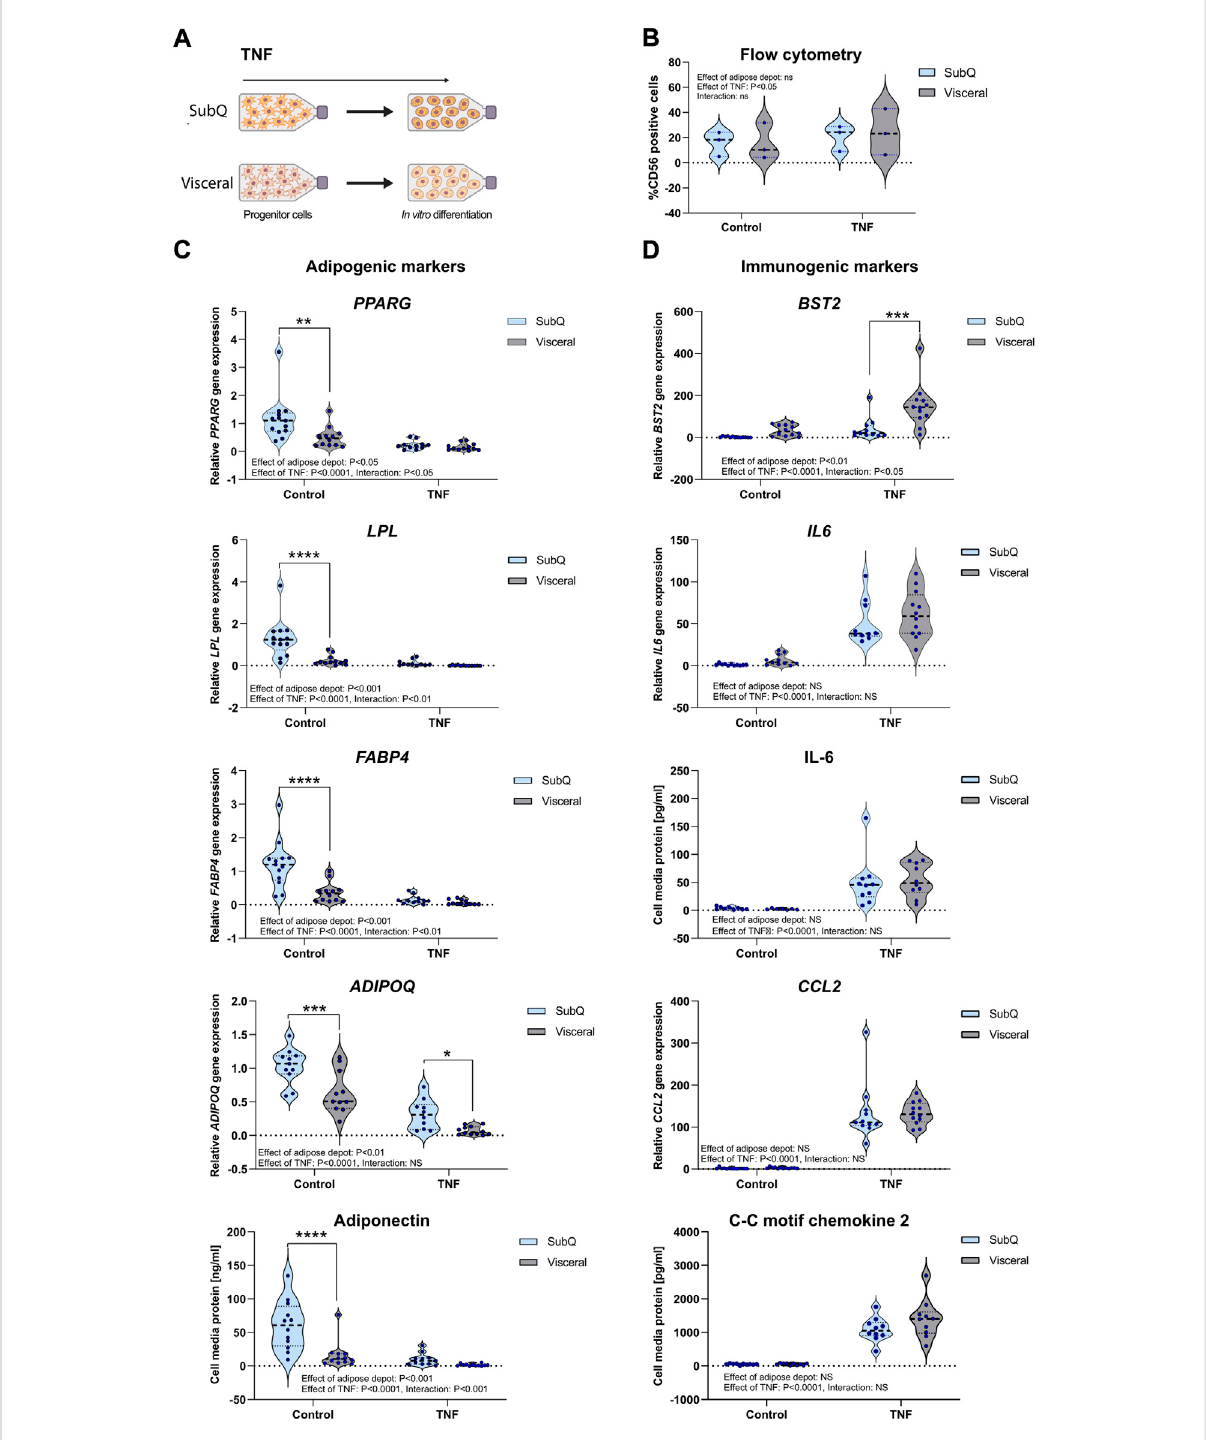
FIGURE 4 Adipogenic and immunogenic gene expression in APSCs stimulated with TNF during differentiation. APSCs derived from SAT and VAT of non- obese women ( n = 13) were differentiated in media supplemented with TNF or saline control. (A) Cartoon showing experimental set-up. (B) Flow cytometry measuringCD56 + positivecellsinAPSCsexposedto10 ng/mlTNForsalinecontrolfor48 h( n =3/condition). (C) qPCRanalysiswasused to measure therelativeexpression oftheadipogenic markers PPARG , LPL , FABP4 and ADIPOQ . Adiponectin proteinlevels was measured inthe cellmediausingELISA. (D) qPCRanalysiswasusedtomeasuretherelativeexpressionoftheimmunogenicmarkers BST2 , IL6 and CCL2. IL-6andC-C motif chemokine-2 protein levels were measured in the cell media using ELISA. Data are presented as violin plots with thick dotted line showing medianand thindotted linesshowing quartiles. Two-way anovaassesseddifferencebetweengroupsanddepots.Resultsfrom signi fi cantpost-tests are shown as: * p < 0.05, ** p < 0.01, *** p < 0.001, **** p <